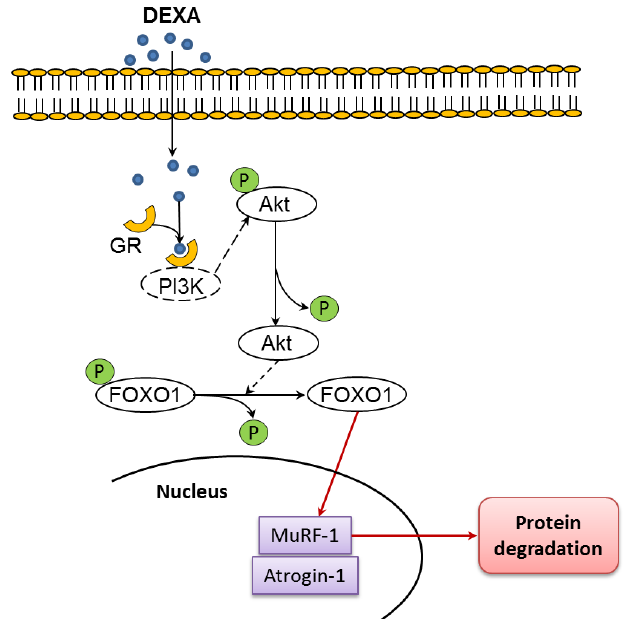
Figure 1. Upregulation of atrogin-1 and MuRF1 by glucocorticoids have been linked to activation of Forkhead BoxO (FOXO1) and FOXO3A resulting from reduced protein kinase B (Akt) activity. Atrogin-1 and MuRF1 are two muscle-specific ubiquitin ligases linked to muscle atrophy when upregulated. Glucocorticoid receptor: GR. Modified by Chen et al. [13].